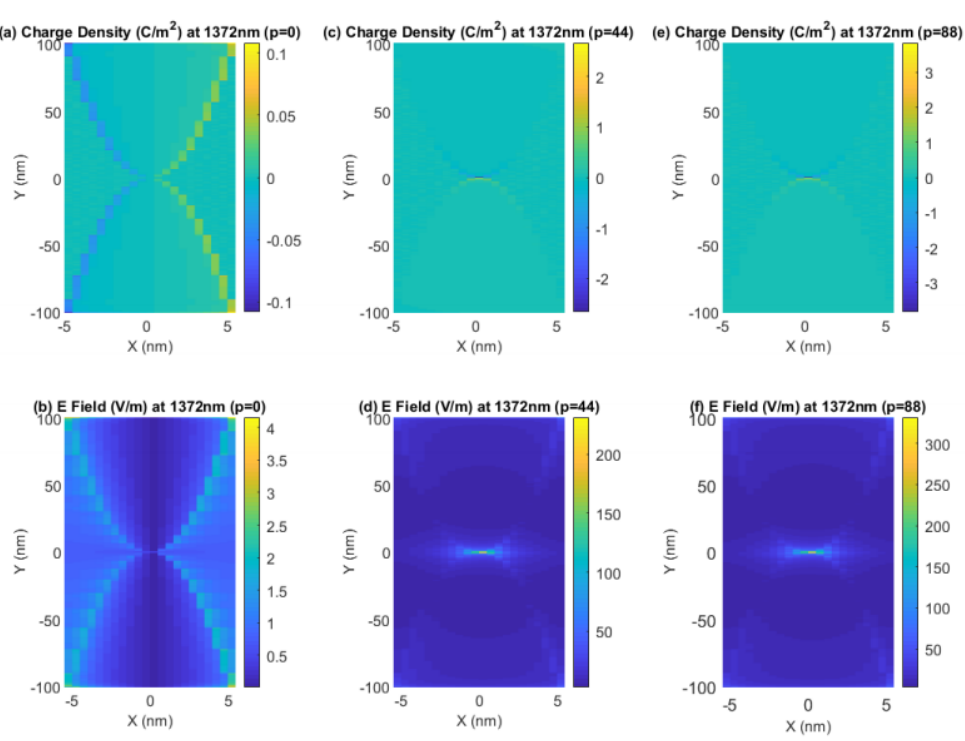
Figure 7. Charge density and electric field on surface of the PGNB illuminated under sources with different polarization angles (wing length: L = 100 nm, wing width: W = 10 nm, gold thickness: H = 50 nm, gap size: Gap = 0.9 nm). ( a , b ): Charge density and electric field under illumination of source with an incident wavelength of 1372 nm and a polarization angle of zero. ( c , d ): Charge density and electric field under illumination of source with an incident wavelength of 1372 nm and a polarization angle of 44 degrees. ( e , f ): Charge density and electric field under illumination of source with an incident wavelength of 1372 nm and a polarization angle of 88 degrees.